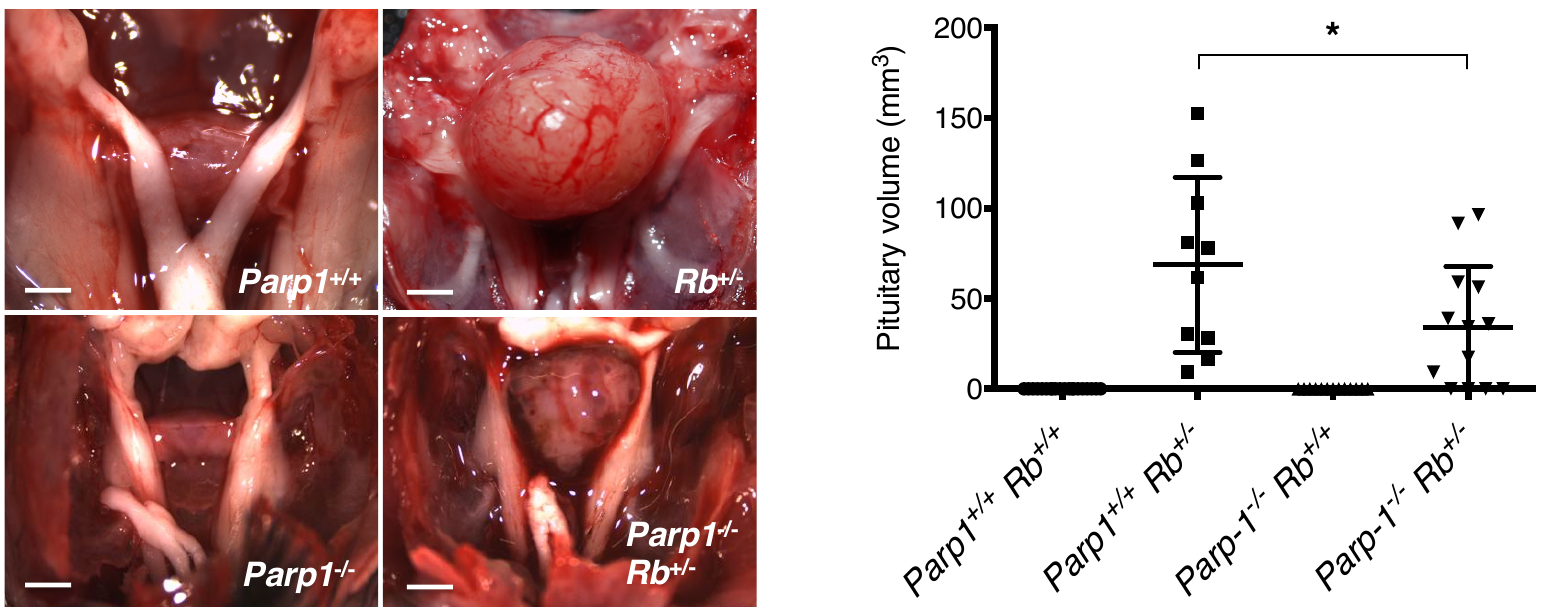
Figure 2. Loss of Parp1 reduces pituitary adenoma number and size in Rb +/ − mice. At 8 months of age, pituitary tumours not only occurred in a smaller percentage of Parp1 − / − Rb +/ − mice than Parp1 +/+ Rb +/ − mice, but also the presence of Parp1 was associated with higher tumour volume (* p < 0.05). Scale = 2 mm. Representative images of pituitary